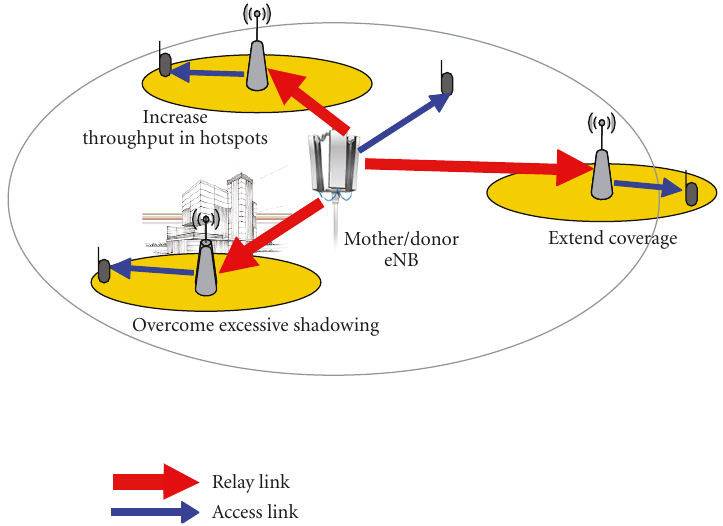
Figure 1: Examples of an LTE radio access network deployment with fixed relay